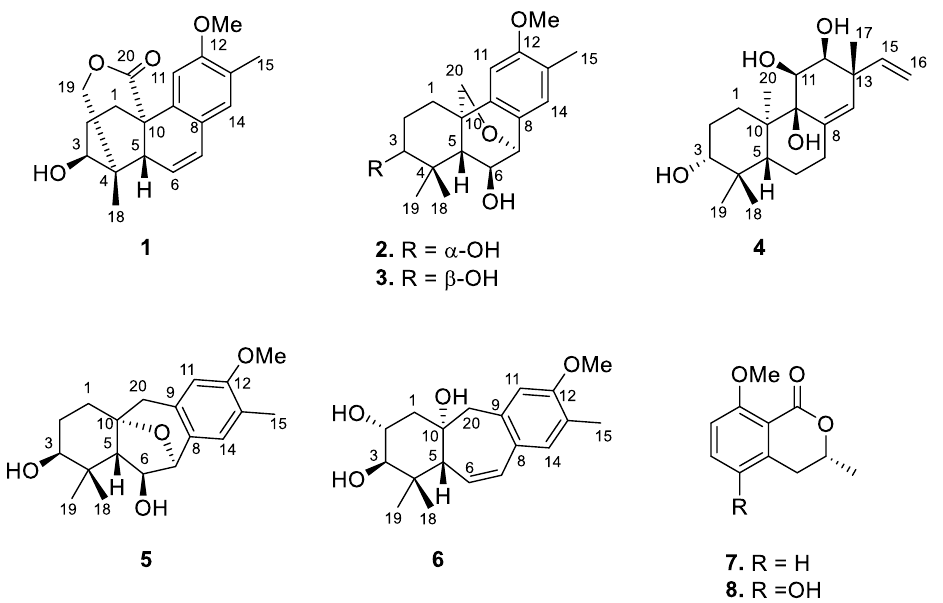
Figure 1. Structures of compounds 1 – 8 .